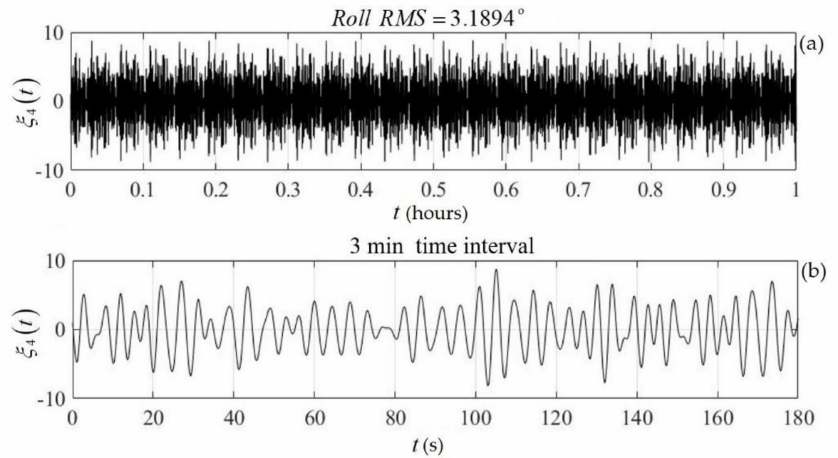
Figure 10. Simulated time series of the floating twin-hull structure’s roll motion. Total breadth B ( T ) = 20 m at a depth h = 30 m in the case of incident waves with a significant wave height equal to H S = 0.5 m and a peak period T P = 4s. ( a ) A 1 h long time series and ( b ) indicative roll motion over a 3 min long